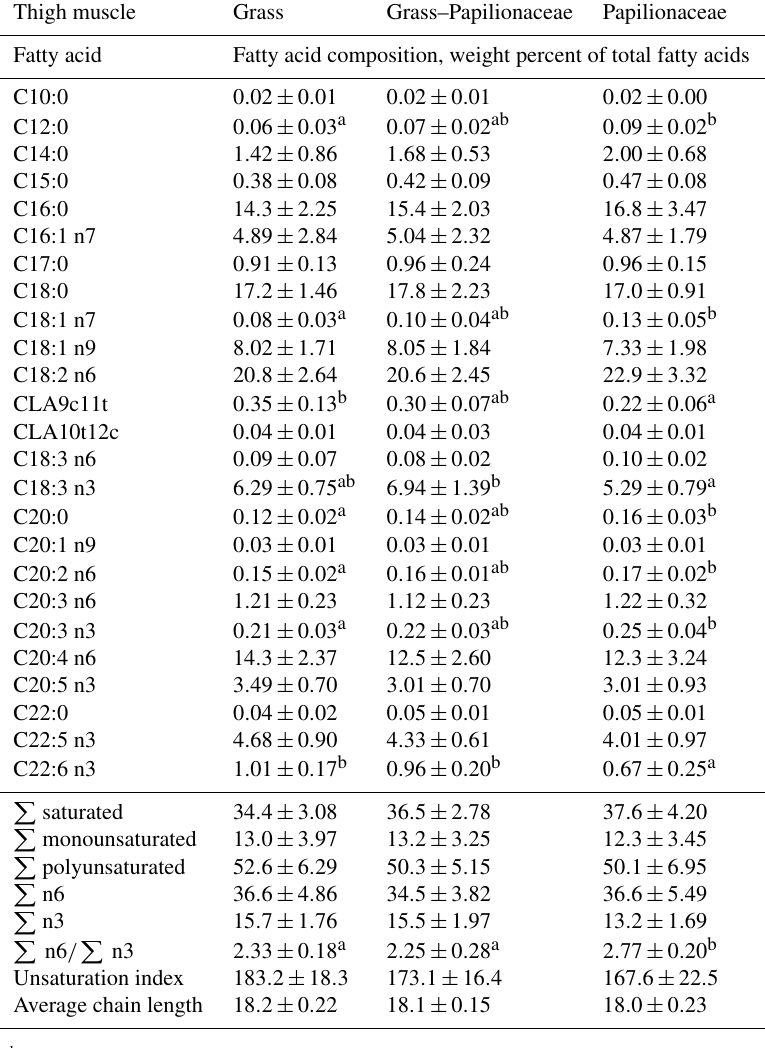
Table 5. Fatty acid composition of the thigh muscle of the three deer groups ( n = 10 per group, means ± SD). Thigh muscle Grass Grass–Papilionaceae Papilionaceae Fatty acid Fatty acid composition, weight percent of total fatty